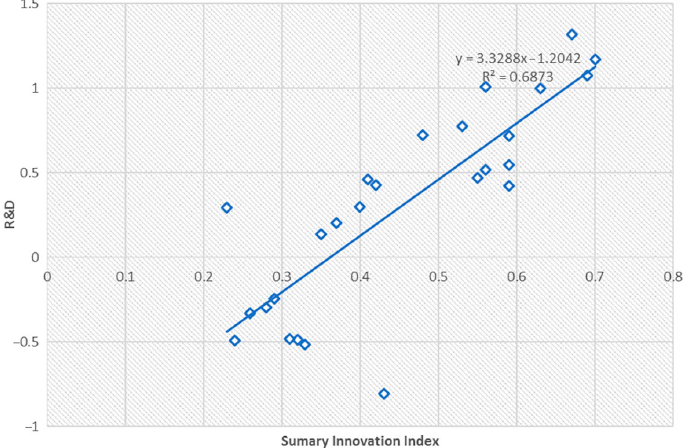
Figure 2. Relationship between R&D and innovation for the entire sample in